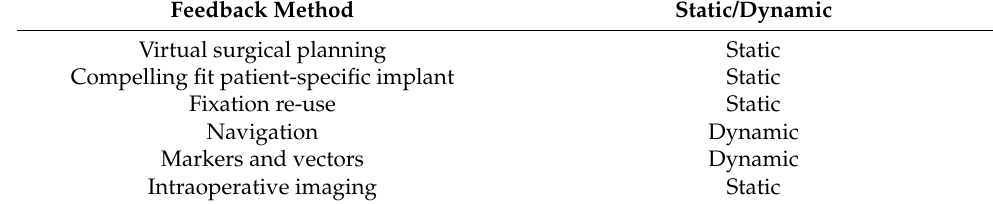
Table 2. Different feedback methods available in the operation room.